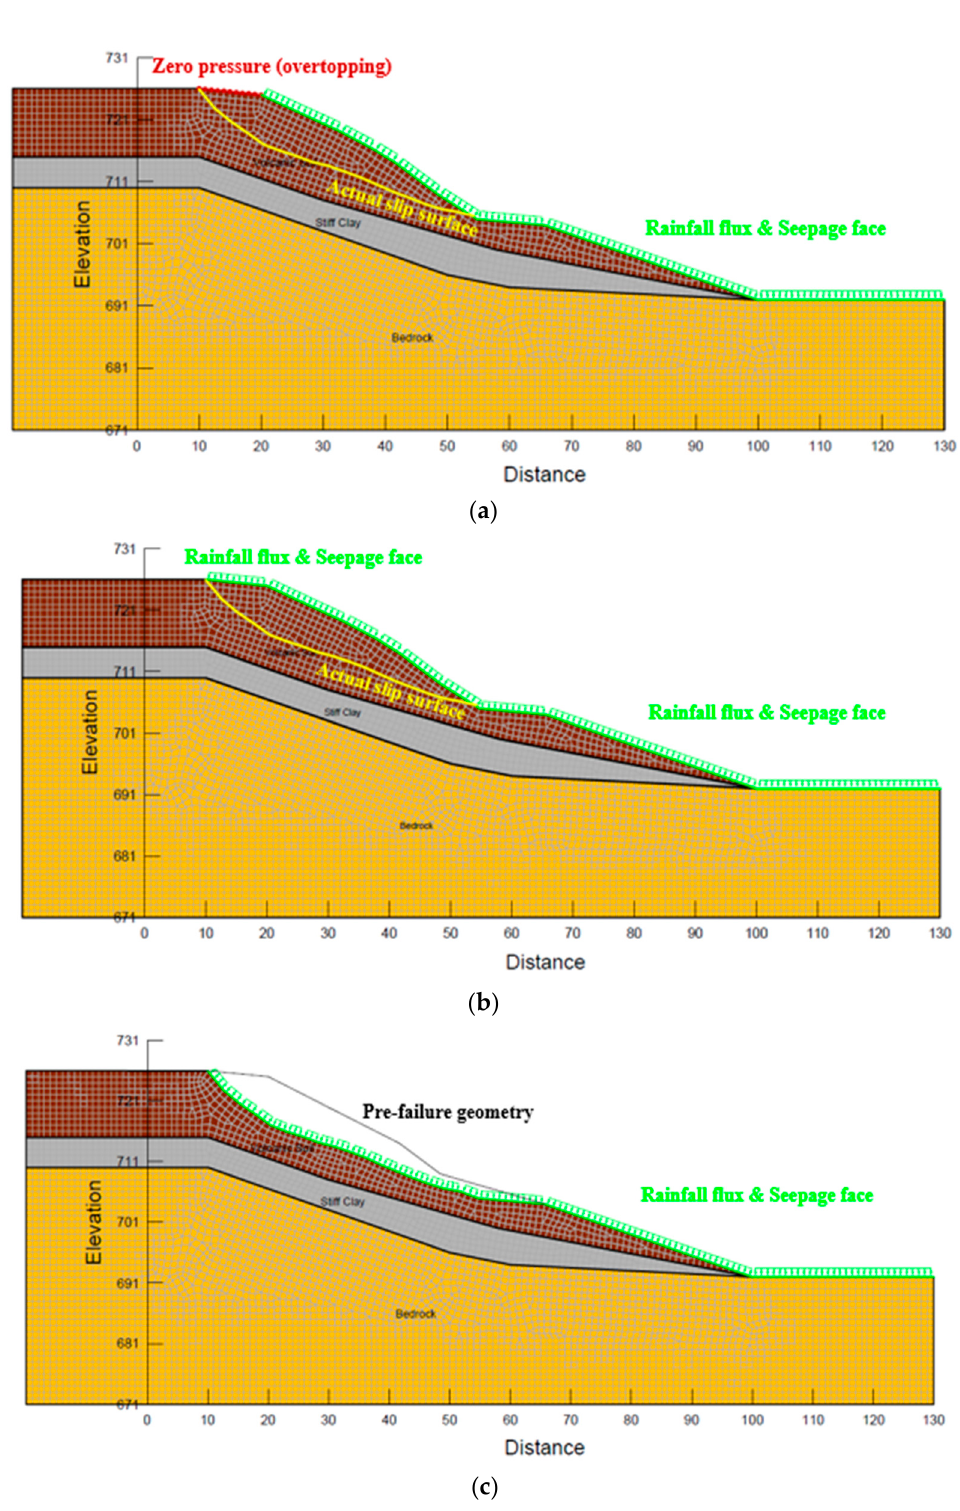
Figure 8. Post-landslide slope contour.